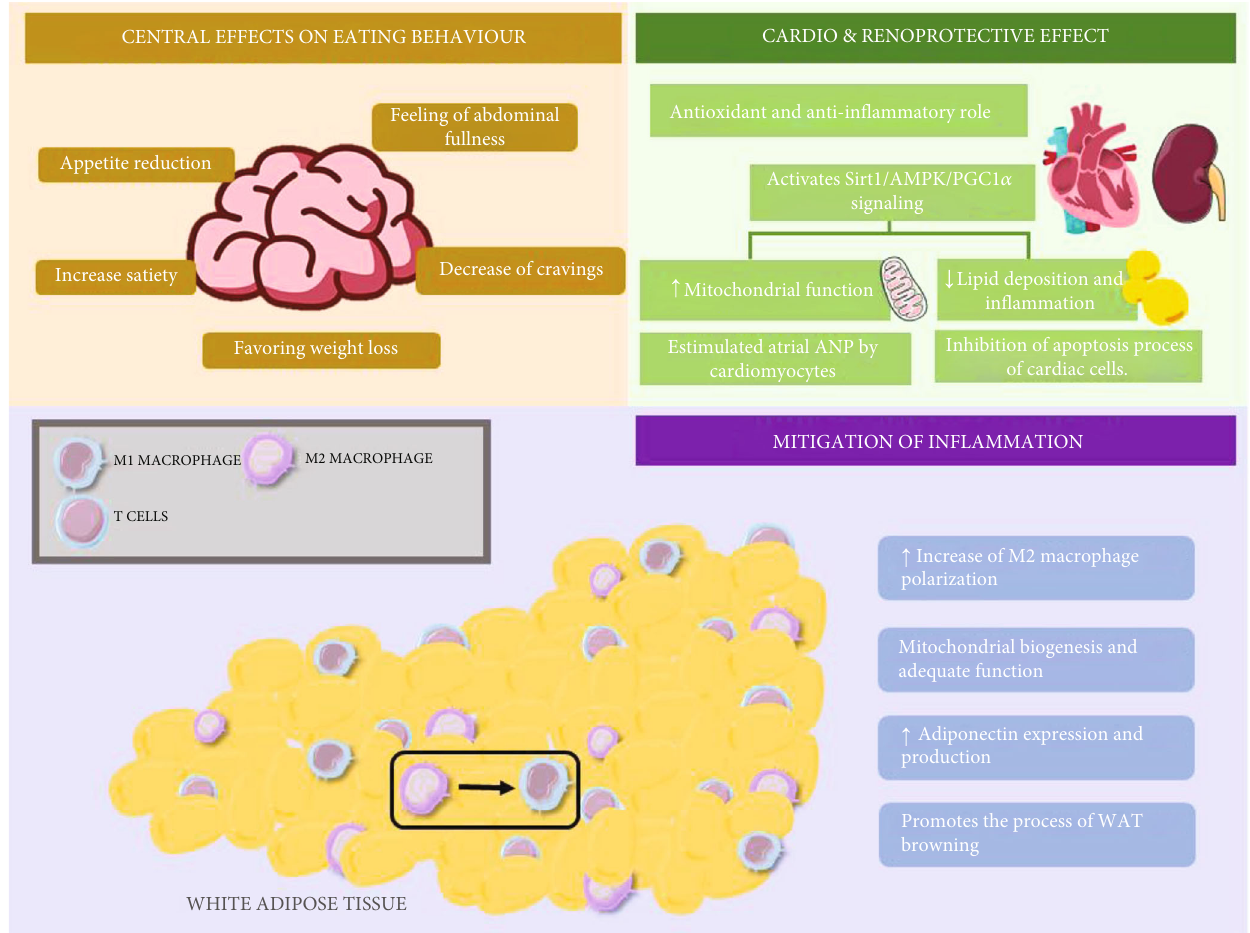
Figure 3: Role of GLP-1RA in obesity, adipose tissue in fl ammation, and cardiac and kidney disease. In obesity, glucagon-like peptide 1 agonist (GLP-1RA) e ff ects are related to its capacity to penetrate the blood-brain barrier and the presence of the glucagon-like peptide 1 receptor (GLP-1R) in di ff erent brain regions, resulting in appetite reduction, increase in satiety, and abdominal fullness and a decrease in food cravings. This, in turn, favors a weight loss of 2 to 8kg on average. In the kidneys, an antioxidant and anti-in fl ammatory role has been reported. Via the activation of the Sirt1/AMPK/PGC1 α signaling pathway, it partially restores the function of renal mitochondria and decreases lipid deposition and in fl ammation in the kidneys. Lastly, its role has been proven in the mitigation of in fl ammation since it favors macrophage polarization and adiponectin production while promoting mitochondrial biogenesis and adequate function, as well as adipose tissue browning. GLP-1RA: glucagon-like peptide 1 agonists; GLP-1R: glucagon-like peptide 1 receptor; SIRT1: sirtuin 1; AMPK: AMP-activated protein kinase; PGC1 α : Pparg coactivator 1 alpha; WAT: white adipose tissue; ANP: atrial natriuretic